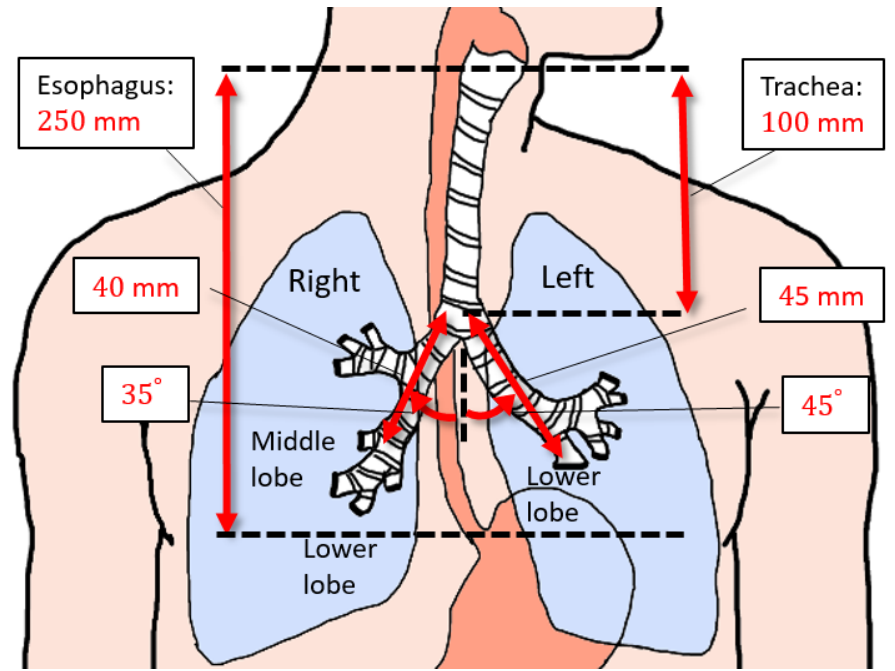
Figure 2. Dimensions of the esophagus and airway where the NGT can